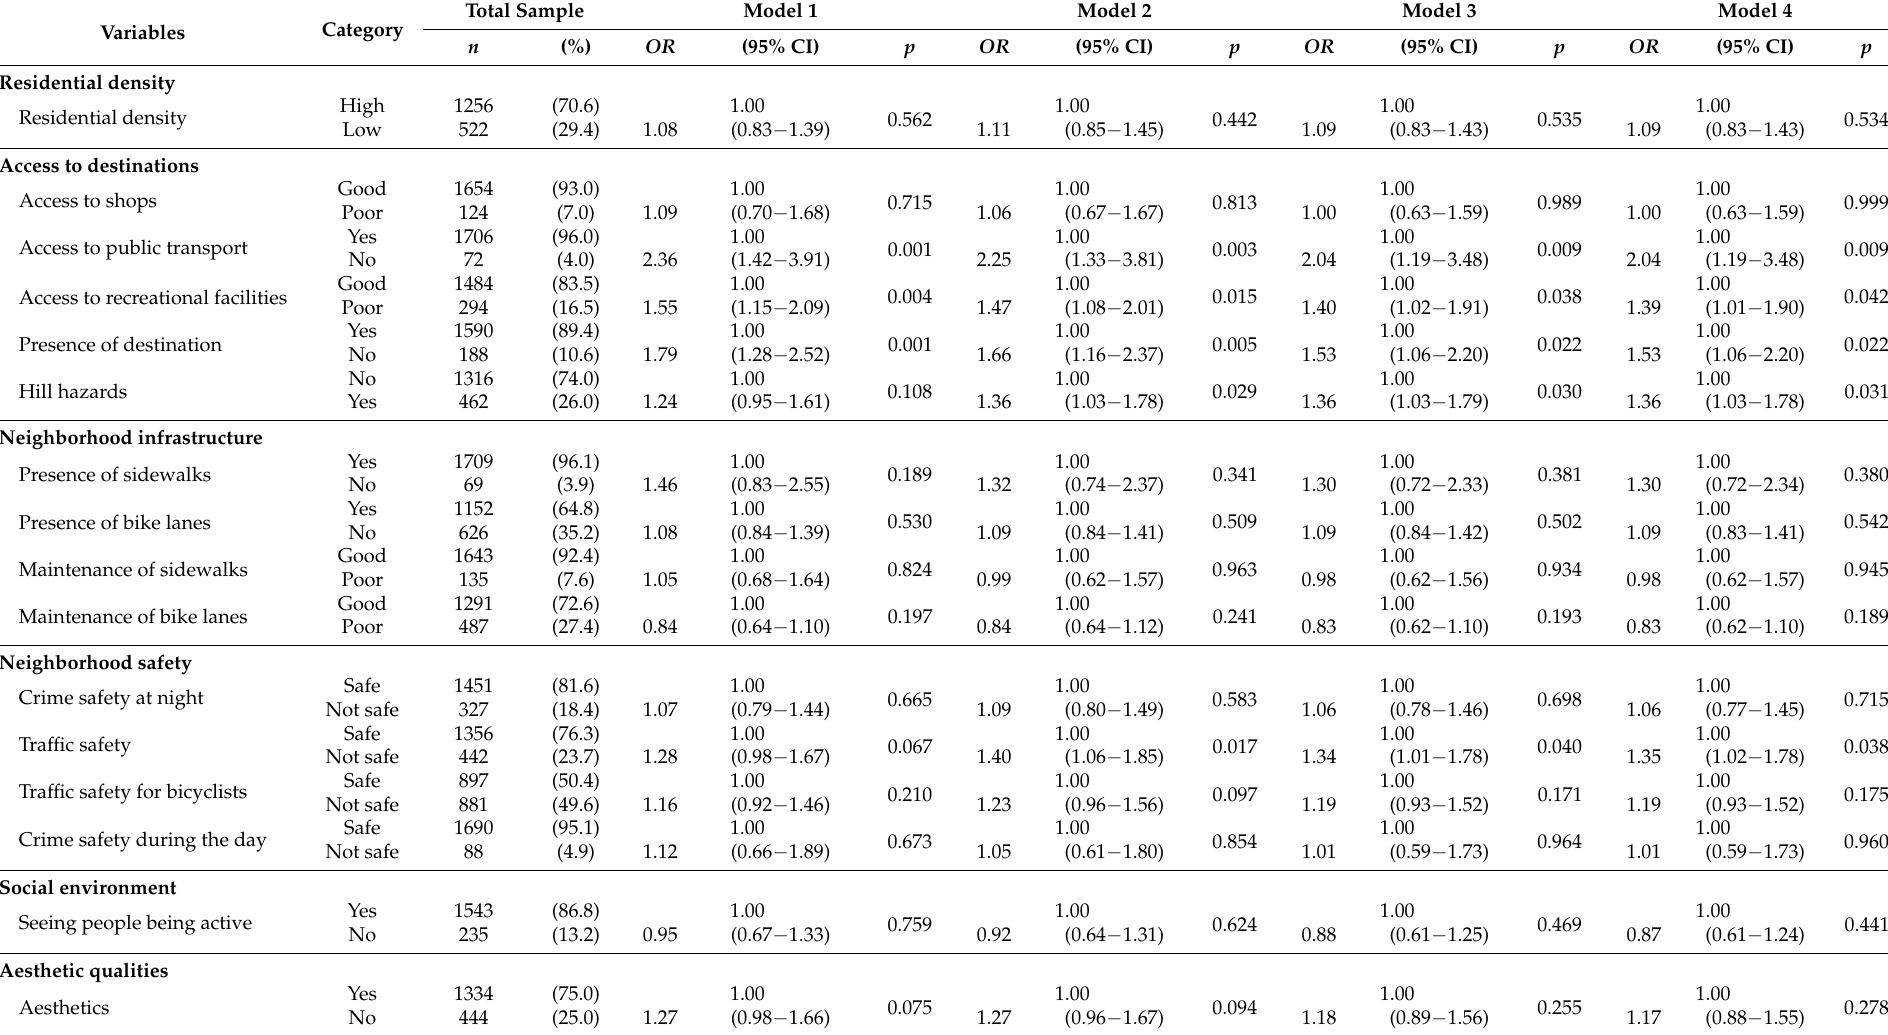
Table 2. Adjusted odds ratios of neighborhood environmental factors for sarcopenia ( n =